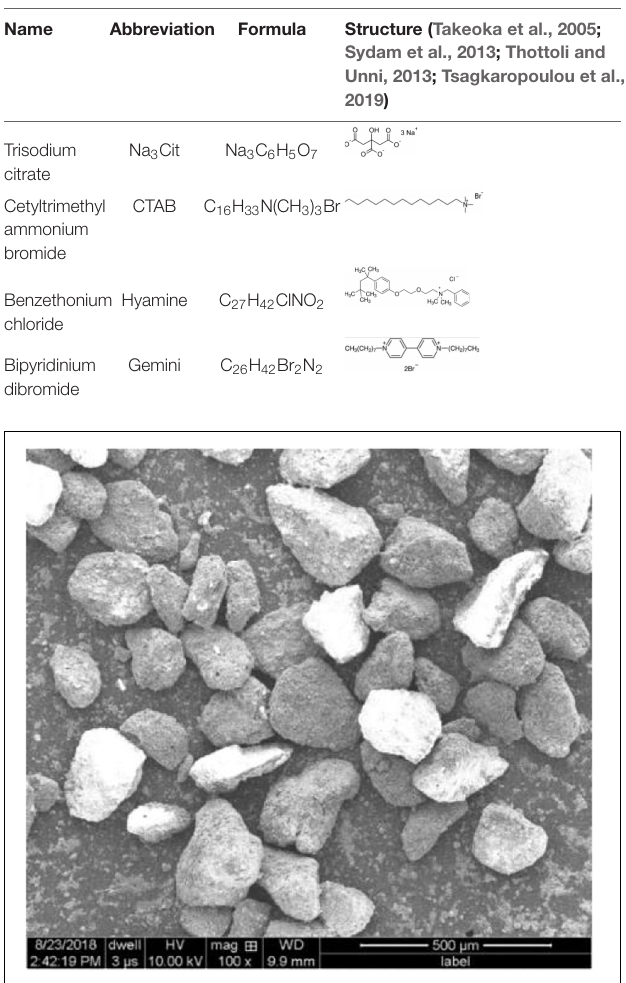
FIGURE 1 | SEM image of Fayetteville shale rocks (106–250 µ